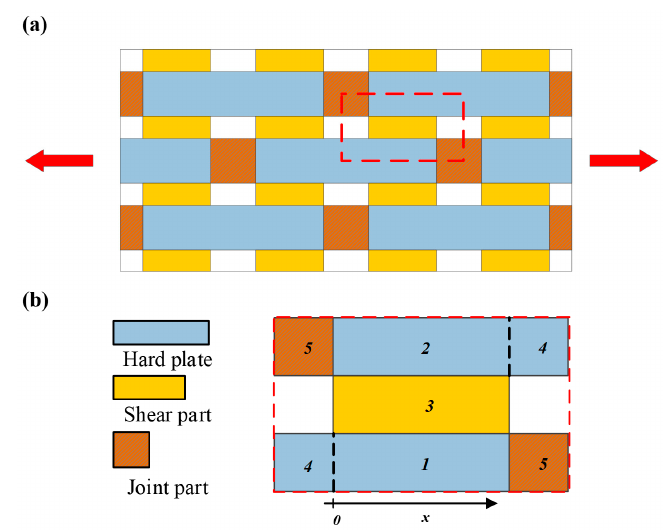
Figure 1. ( a ) Schematic image of our biomimetic composite structure under uniaxial tensile load. ( b ) The unit cell defined in this paper, with the region partition 1 to 5 and coordinate definitions.